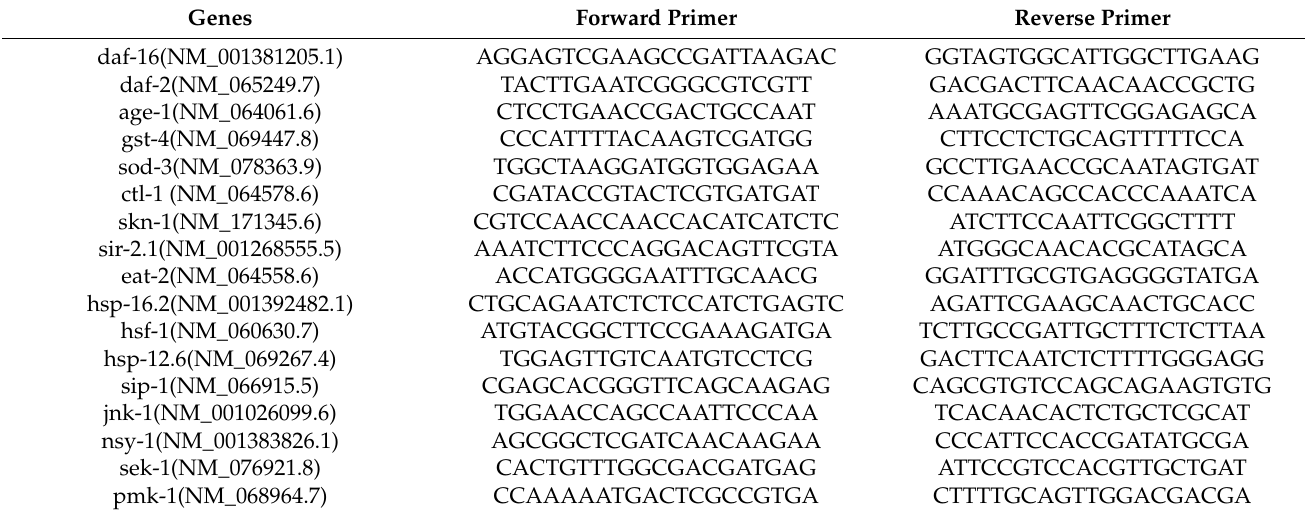
Table 1. The primer sequence of the